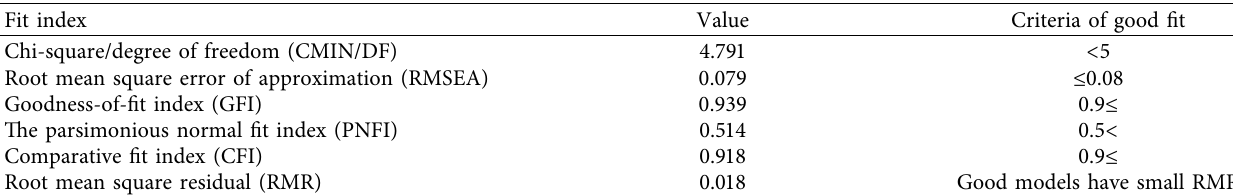
Table 6: Modeling fit